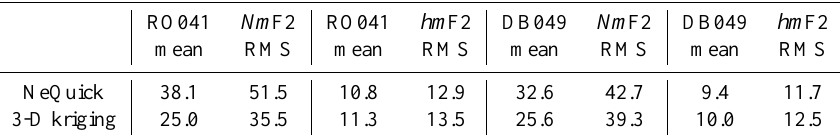
Table 1. Comparison of the relative absolute errors of the NeQuick model and the 3-D kriging at the ionosonde station locations of DB049 and RO041 for DOY 22 (2011), all values are given in